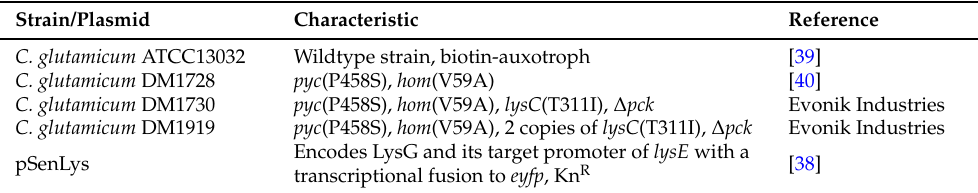
Table 1. Used C. glutamicum strains and plasmids: The mutated strains contained the following point mutations: pyc (P458S) leads to increased pyruvate-carboxylase activity, hom (V59A): leads to decreased homoserine-dehydrogenase activity, lysC (T311I): feedback resistant aspartate kinase, and the deletion of ∆ pck encoding the phosphoenolpyruvate